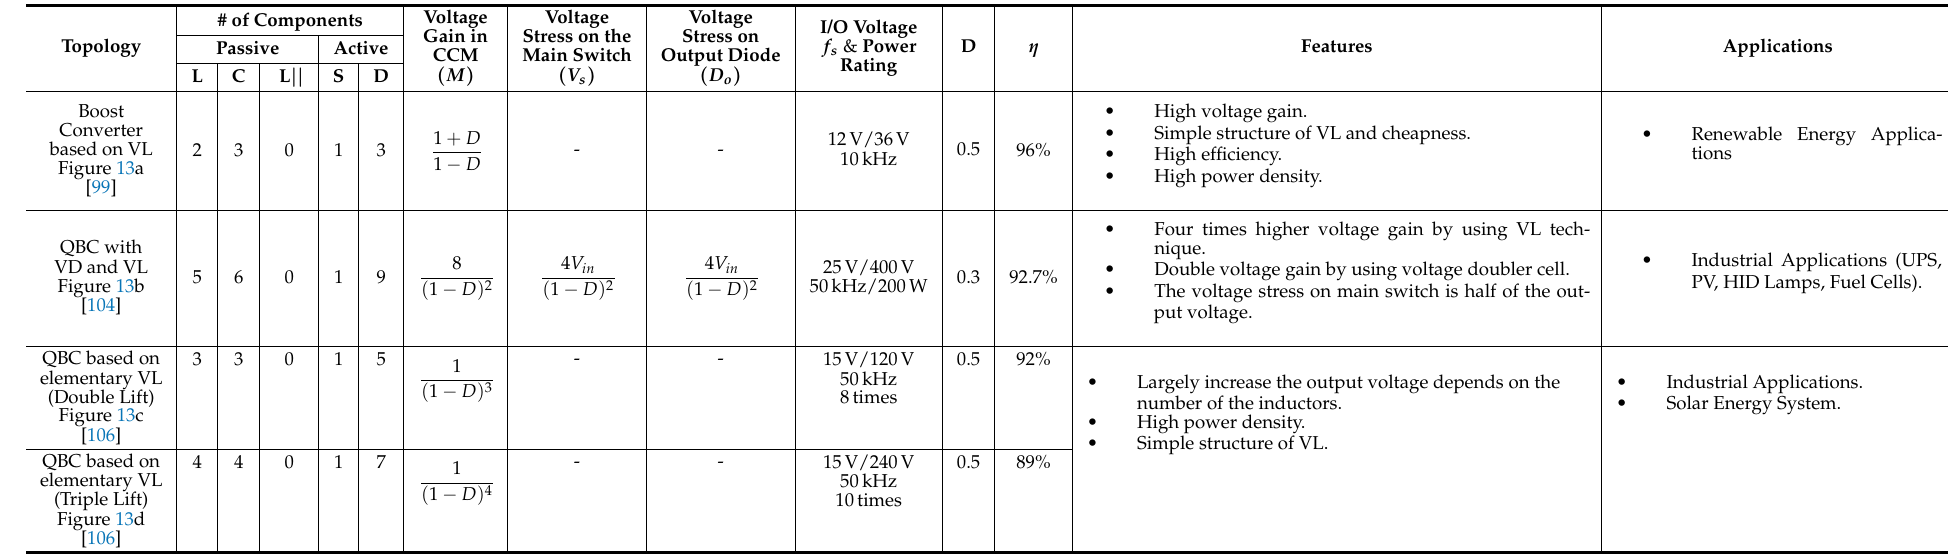
Table 7. Comparison of Voltage Lift (VL)